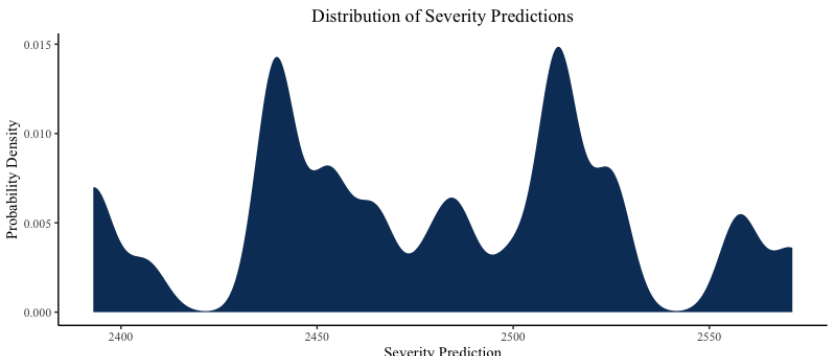
Figure A1. The frequency model’s predicted probability of the final COLL model. The left pane shows the density of the predicted probability for 0 claims, while the right pane shows the density of the predicted probability of 1 claim. These plots help demonstrate what the predictive distribution of the model looks like.